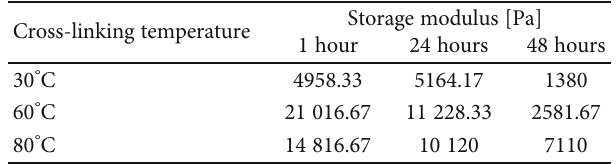
Table 2: Dependence of storage modulus on cross-linking temperature after swelling intervals of 1, 24, and 48